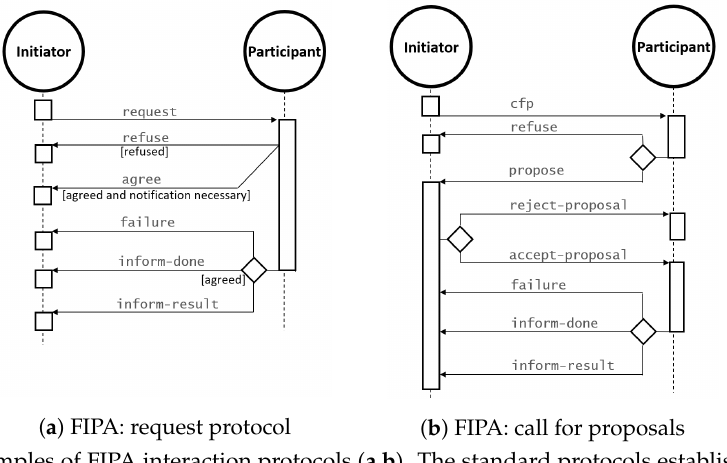
Figure 3. Examples of FIPA interaction protocols ( a , b ). The standard protocols establish the way in which agents interact, providing an abstraction of generic message